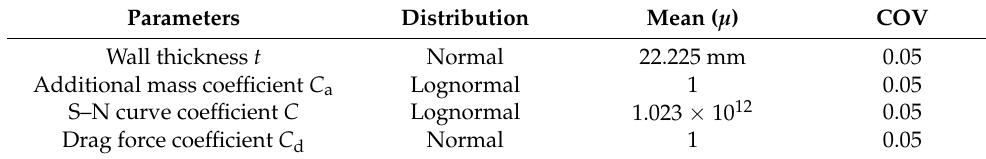
Table 3. Random parameters distributions.